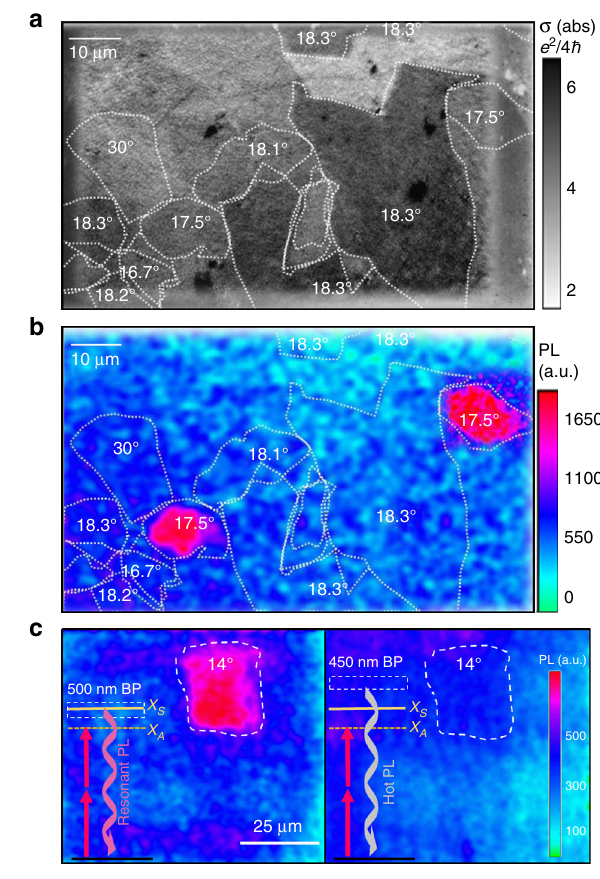
Fig. 2 Maps of tBLG absorption and PL. a Linear absorption map taken at 2.9 eV excitation shows 20% resonant absorption enhancement of the 18.3° domains. b Scanning PL map of t BLG show resonant PL emission enhancement after 2-photon excitation (2 × 1.26 eV) of the 17.5° domains. The PL detection window is E > 2.65 eV. c PL emission wavelength is veri fi ed using bandpass fi lters to compare on-resonance PL (left, PL from X S ) to off-resonance hot-PL (right) under identical excitation conditions